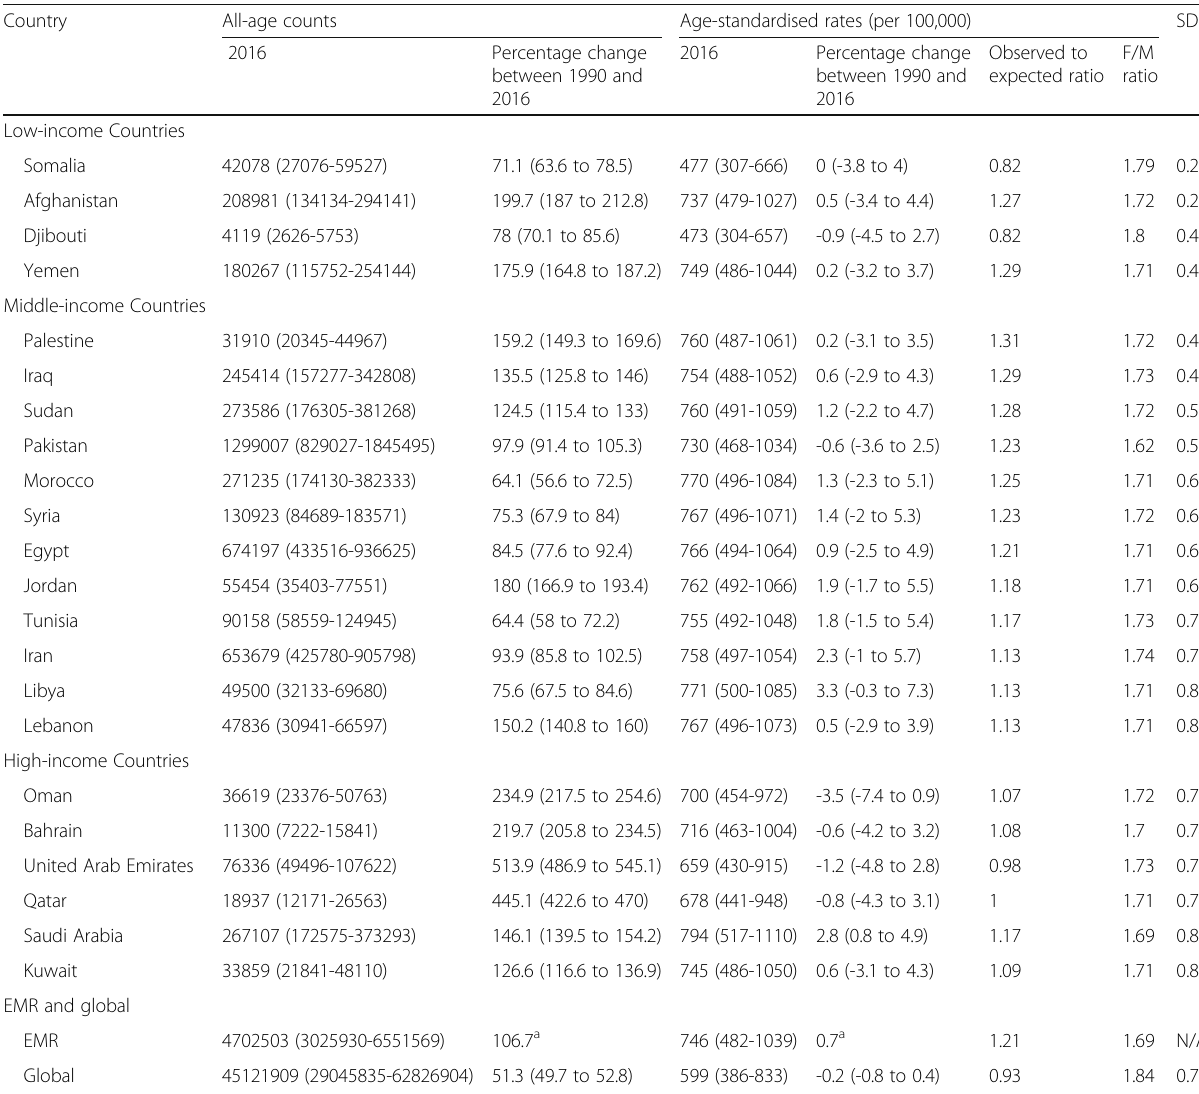
Table 3 YLD count, All-age YLD rates, and Age-standardised rates in 2016, and percentage change of YLD count, All-age YLD rates, and Age-standardised rates between 1990 and 2016 for migraine in EMR countries Country All-age